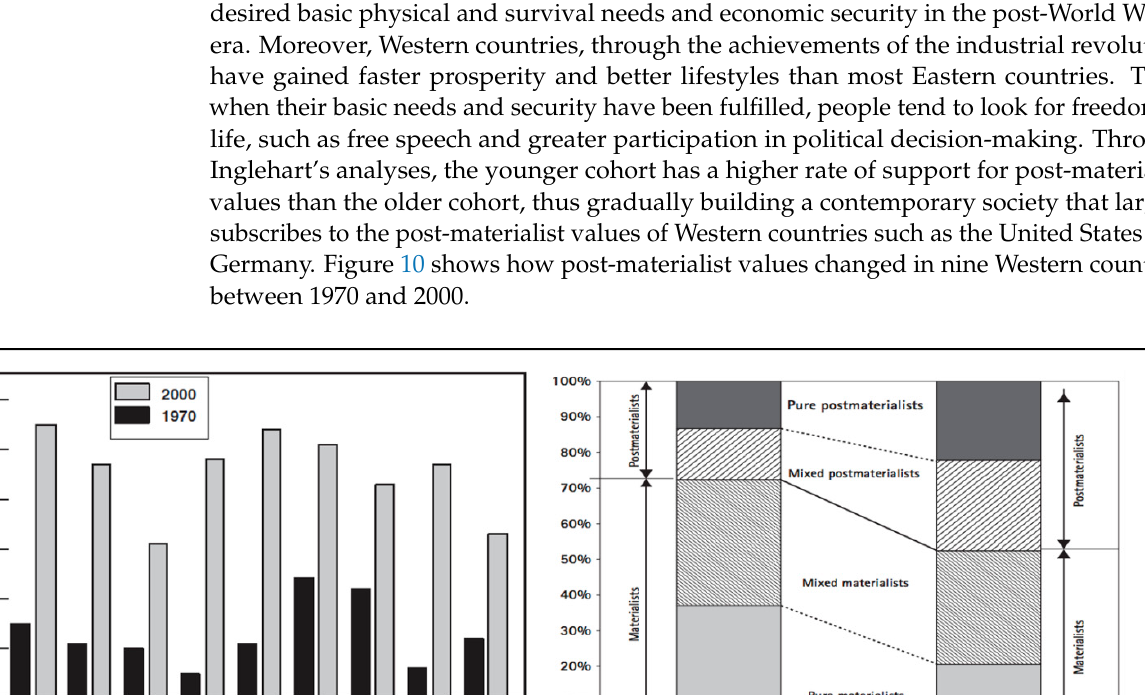
Figure 9. Materialist vs. Post-Materialist for the selected countries. Note: Following the analysis by [40,41], the Order and Economic Security are paired to represent the value of Materialist, while the Political Participation and Free Speech are paired to represent the value of Post-Materialist.